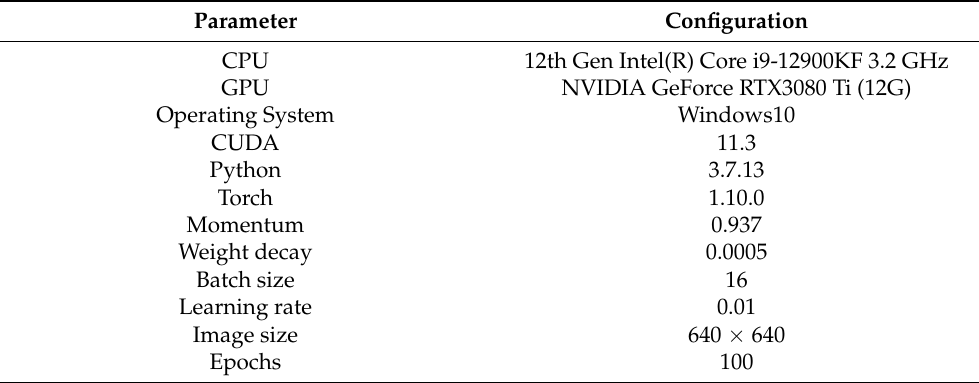
Table 2. Experimental environment